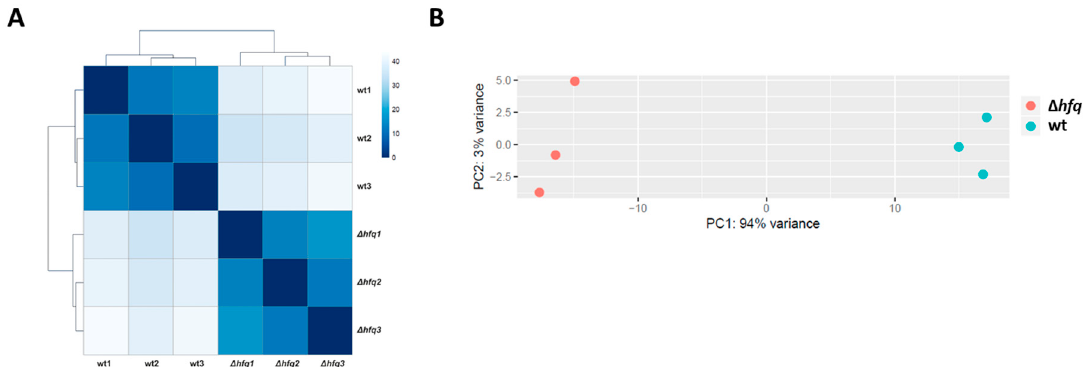
Figure 1. Clustering of transcriptomic data. ( A ) Heat map showing hierarchical clustering of the Euclidean sample-to-sample distance between transcriptomic profiles of wt and ∆ hfq mutant. ( B ) Principal component analysis was applied to transcriptomic profiles of the wt strain (blue circles) and ∆ hfq mutant (red circles). Each dot represents an independent biological replicate.